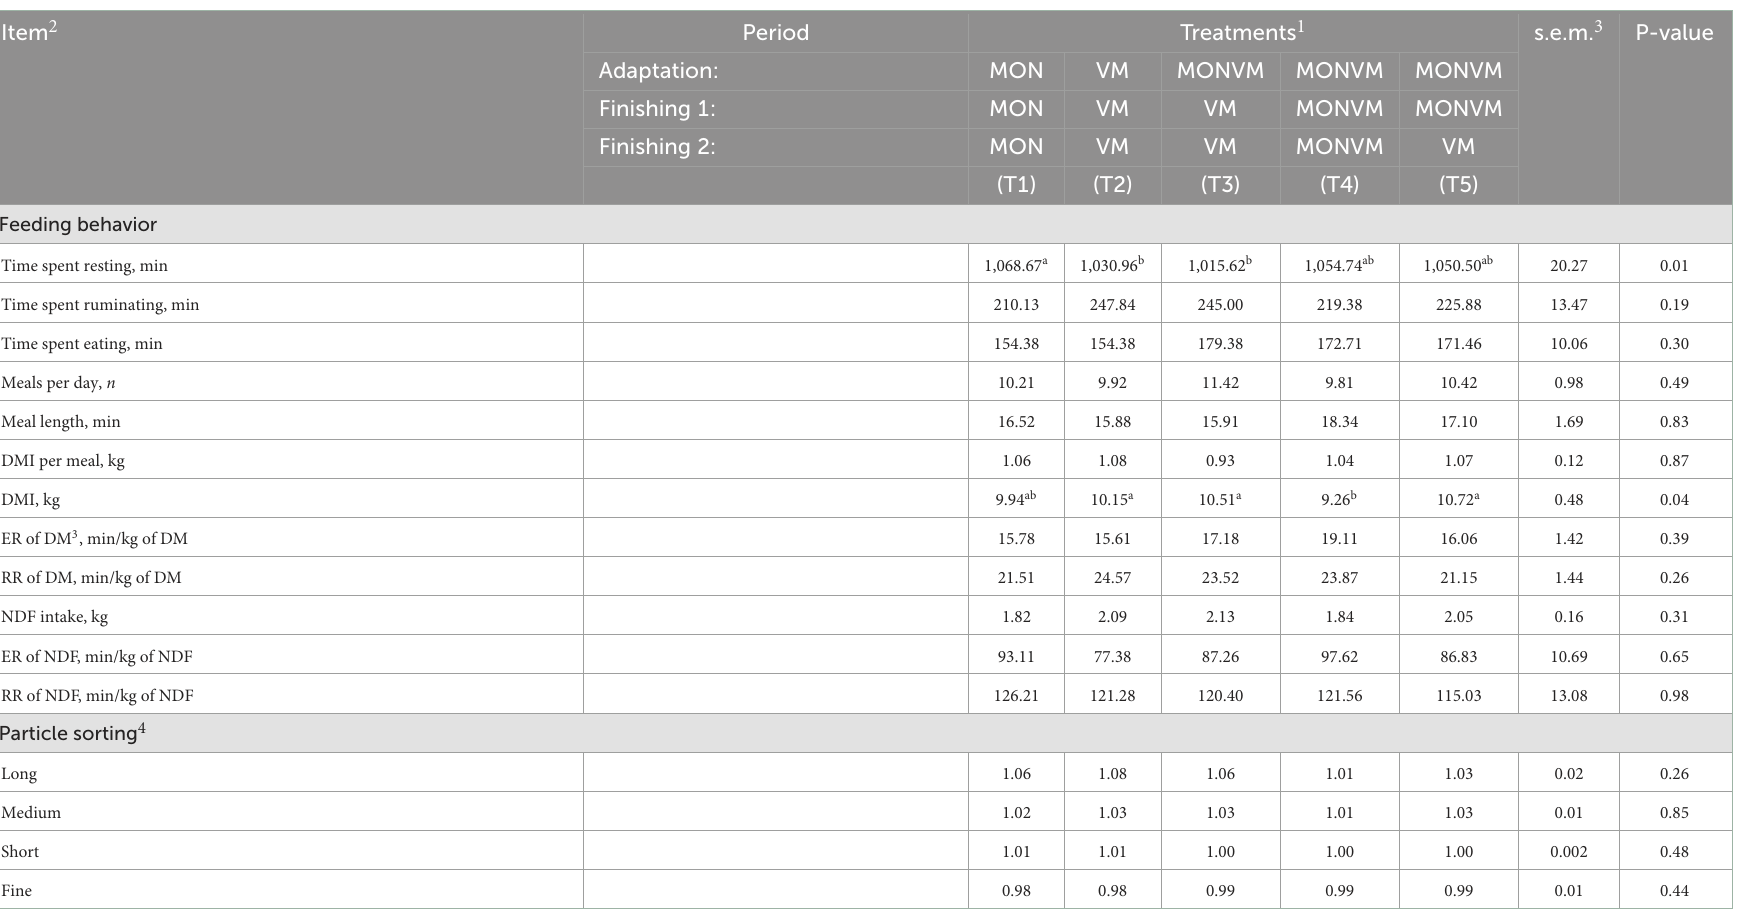
TABLE 5 Withdrawal of sodium monensin when associated with virginiamycin during adaptation and finishing periods on feeding behavior and particle sorting at day 96 (finishing period 2) of Nellore yearling bulls ( n = 30) consuming high-concentrate diets. Item 2 Period Treatments 1 s.e.m. 3 P-value